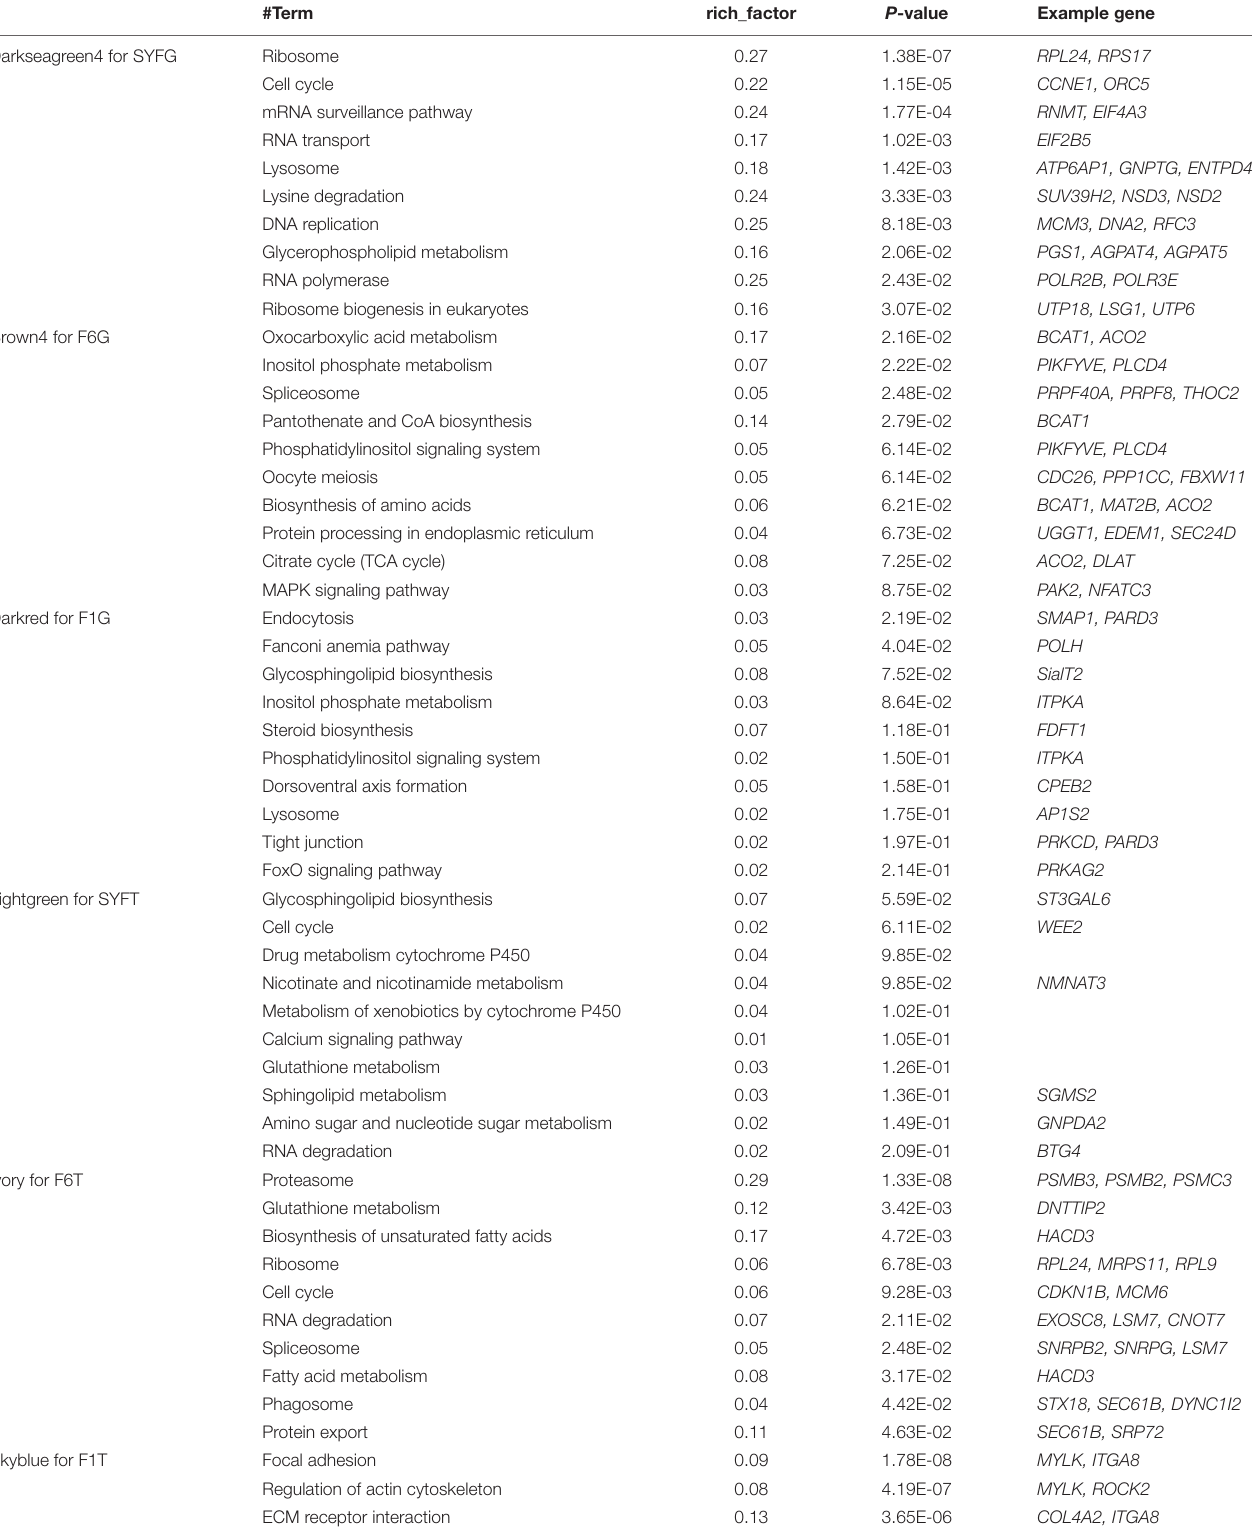
TABLE 5 | Top 10 KEGG pathways of hub genes in different specific